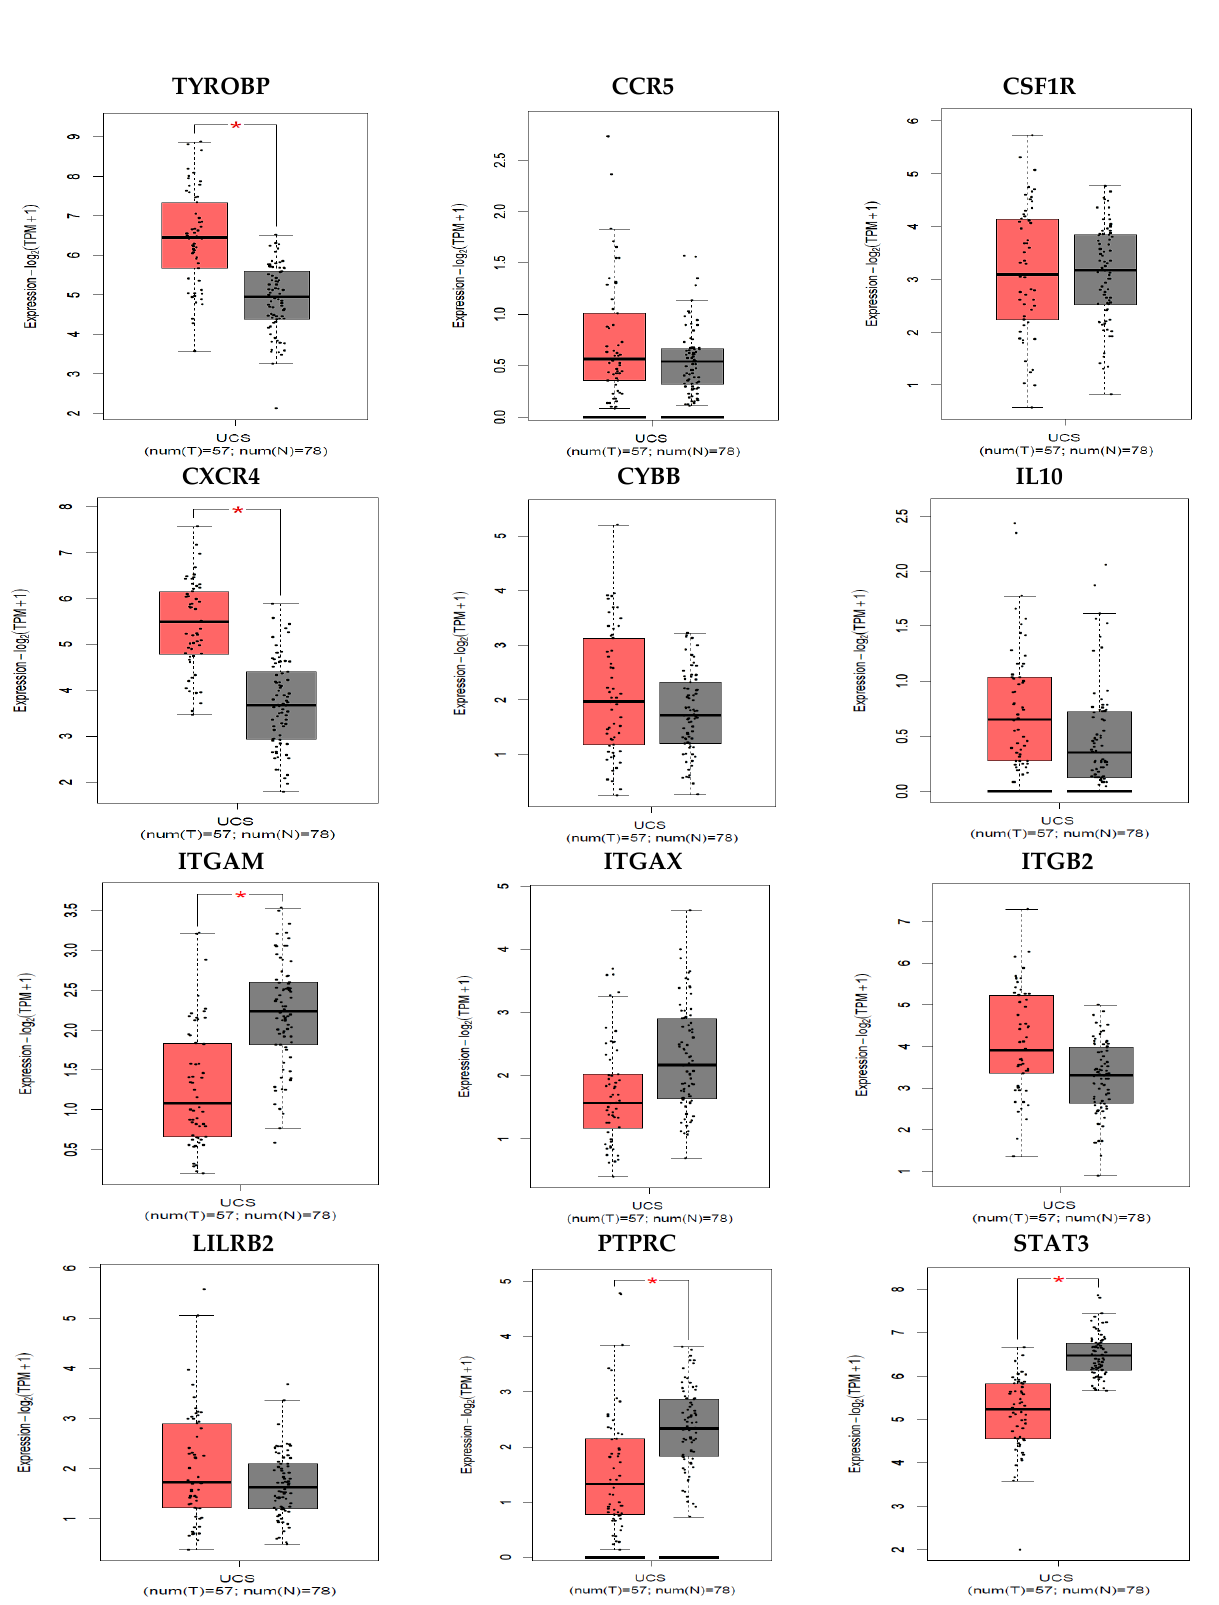
Figure 9. Relative expression levels of hub genes expressed in CC. Red and black boxes represent the relative expression levels of genes in the tumor and normal samples, respectively. The y-axis represents the relative expression levels of genes in terms of log2 (TPM + 1) (tumor samples, 57; normal samples, 78 from GEPIA; p ≤ 0.01). TPM, transcripts per